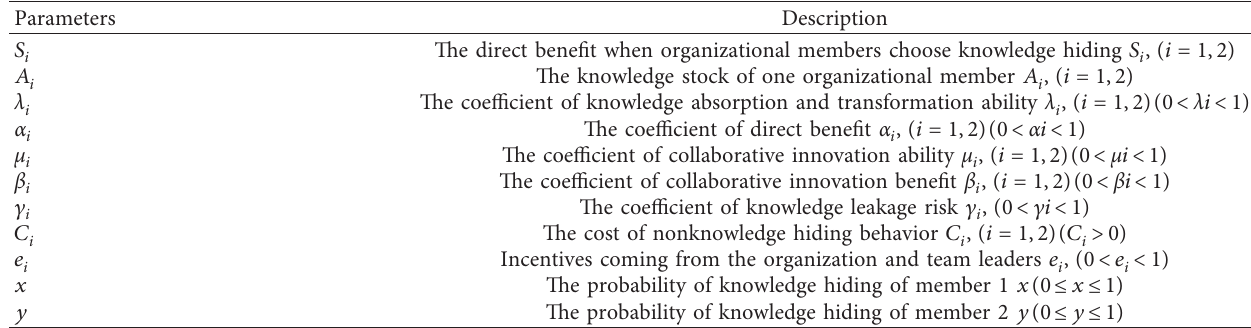
Table 1: Description of parameters.